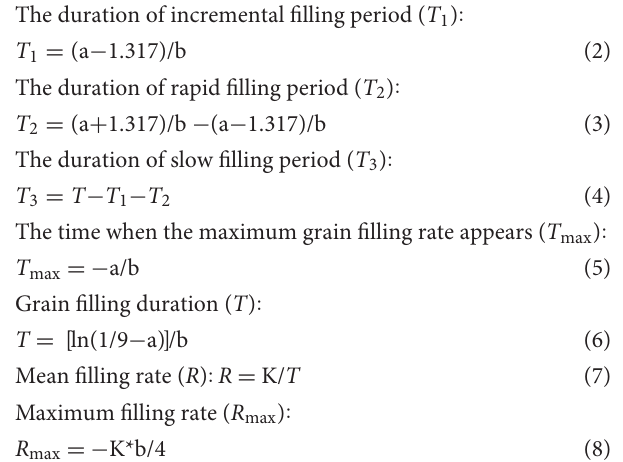
FIGURE 4 | were placed in an artificial climate chamber for LT stress. The temperature was set to 5 ◦ C during 07:00–19:00 and 2, 0, and − 2 ◦ C during 19:00–07:00. The normal growing plants without cold stress were used as controls. The data are presented as the means ± SD ( n = 3). Different lowercase letters indicate significant differences between the treatments determined using the Duncan’s multiple range test ( P < 0.05).